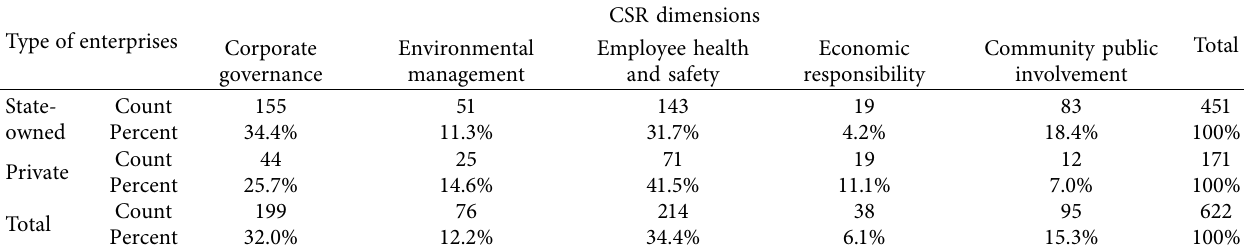
Table 6: Relationship between the type of enterprise and CSR